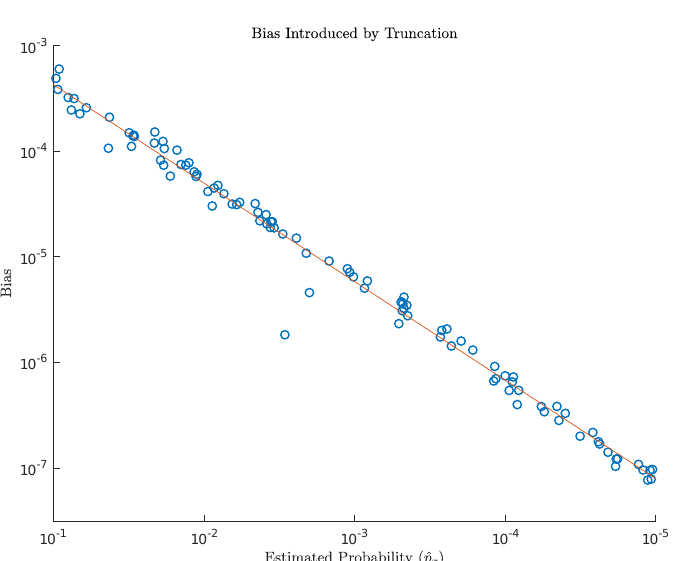
Figure 4. This figure illustrates the bias introduced by trimming large weights (vertical axis) as a function of the probability of interest (horizontal axis), for 100 randomly generated parameter sets in the one-factor case. For each set, we compute bias (in fact, an upper bound on the bias) by using quadrature to approximate Equation (46) and estimate the probability of interest using the full two-stage